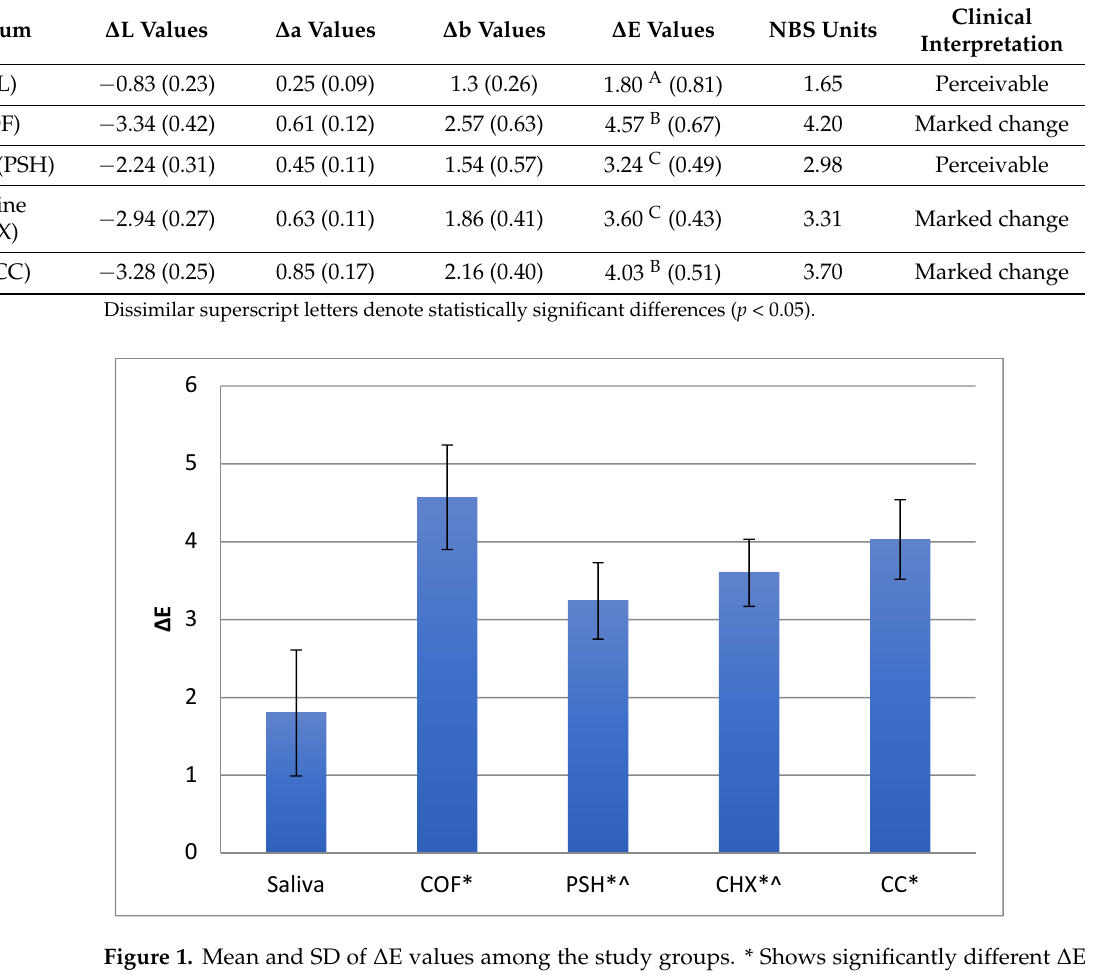
Table 2. ∆ E of zirconia samples in different mediums; values are expressed as the mean (SD).